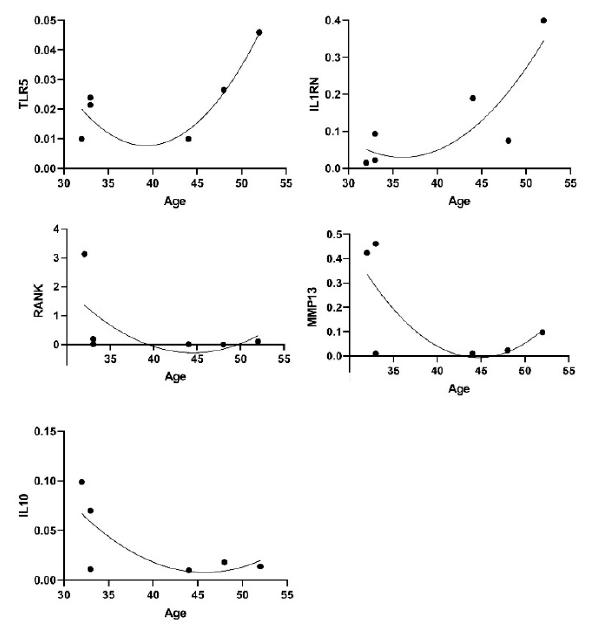
Figure 4. Genes and age associations.